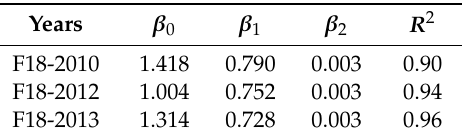
Table 2. Coe ffi cients of satellite